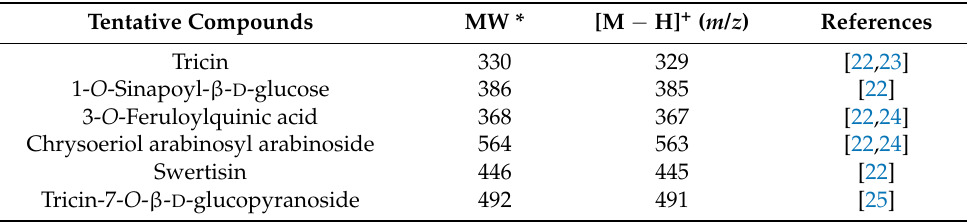
Table 3. Tentative identification of phenolic compounds in ricegrass juice extract (RG) and Se-rich ricegrass juice extract (Se-RG) analyzed by UHPLC–ESI–MS.